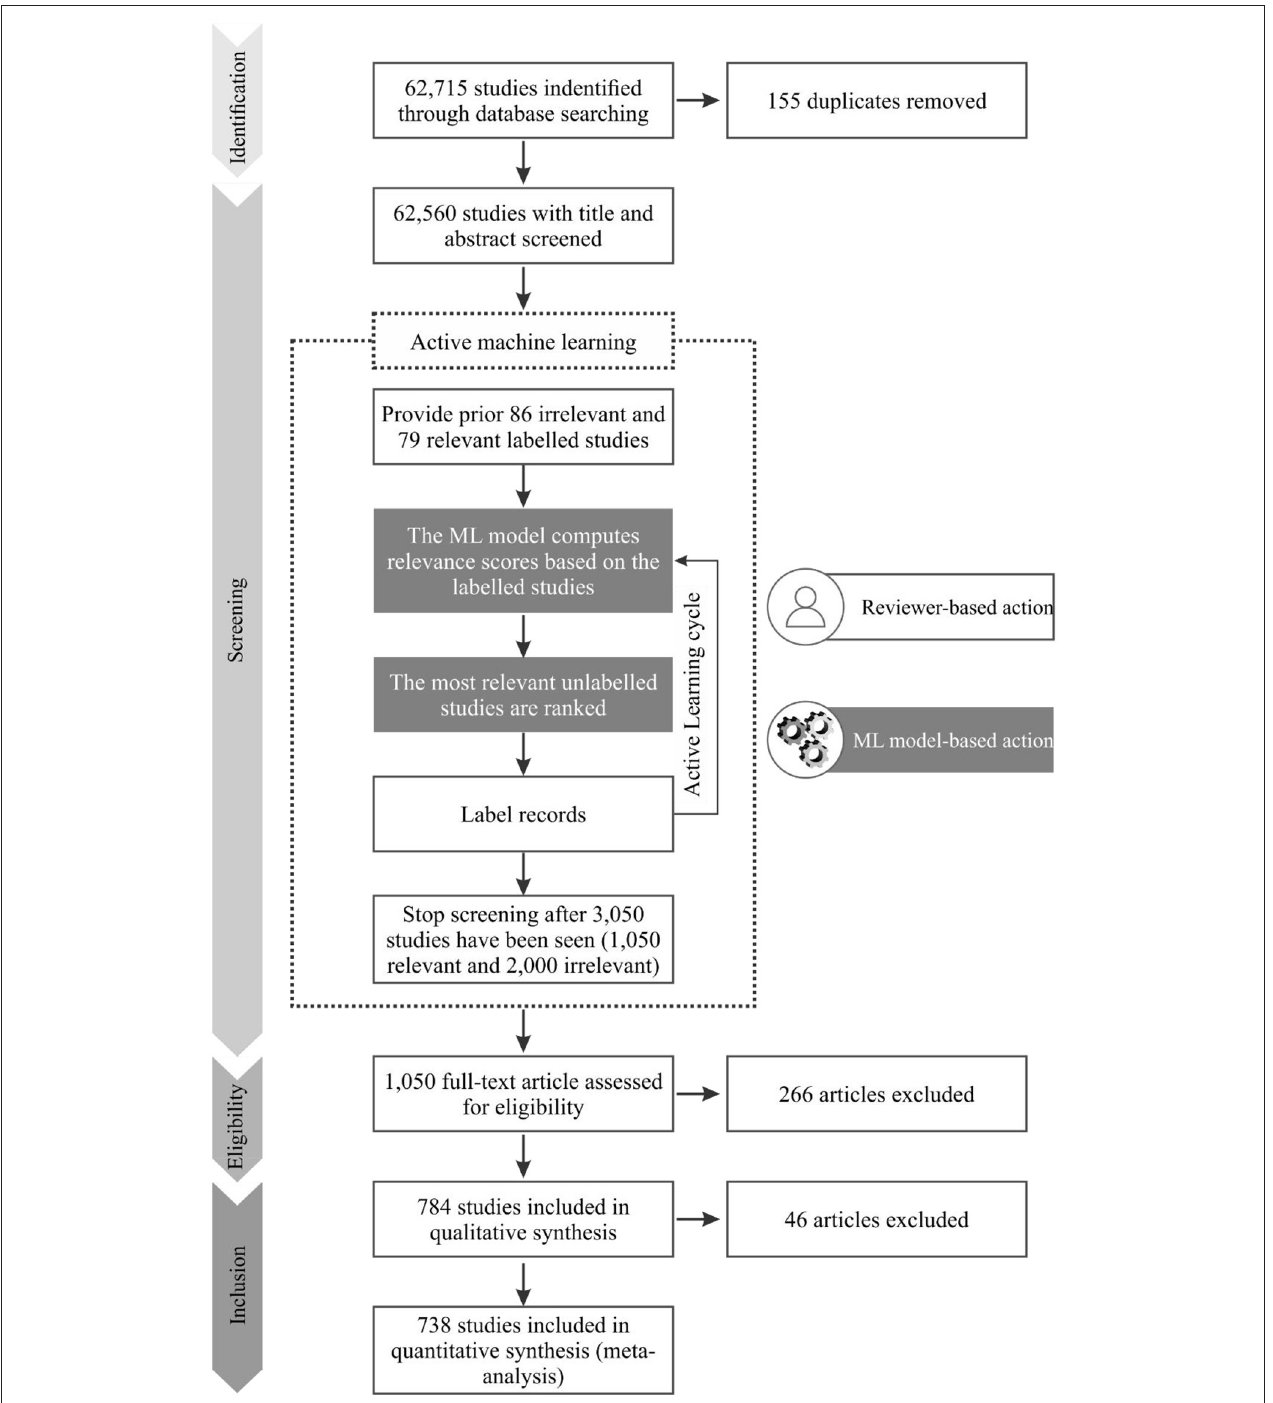
FIGURE 1 | Flowchart depicting the stages (identification, screening, eligibility, and inclusion) of systematic literature review on the toxicological assessment of the impact of agrochemicals on insect pollinators. In the identification stage, duplicates were recognized through the paper titles. The screening of titles and abstracts was performed with active machine learning (ML), in which 165 labeled studies (86 irrelevant and 79 relevant) were included in the ML model. Then, several active learning cycles were performed until 150 irrelevant studies were found in sequence (i.e., 3,050 studies were detected and 1,050 of the most relevant studies were selected). In the eligibility stage, articles ( n = 266) that did not report agrochemical tests with any insect pollinator and/or did not describe the response evaluated in pollinators were excluded. In the inclusion stage, articles that did not assess at least one of the main identified bee groups (honey bees, bumble bees, and stingless bees) were